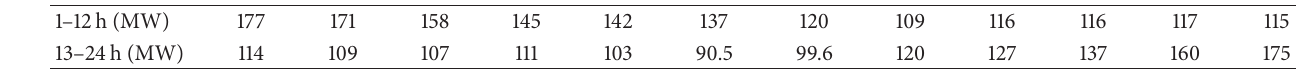
Table 3: Day-ahead forecasted wind power output.